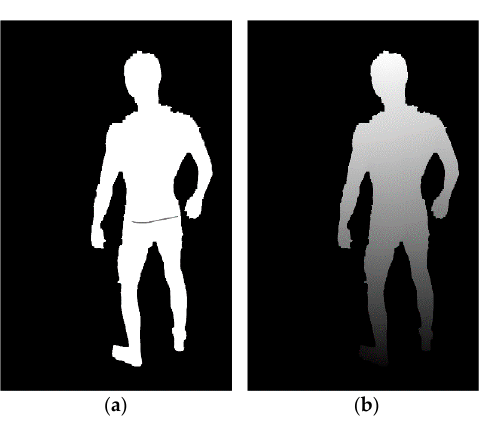
Figure 9. Visualization of the last steps of single-frame processing: ( a ) Mm; ( b ) Fm.